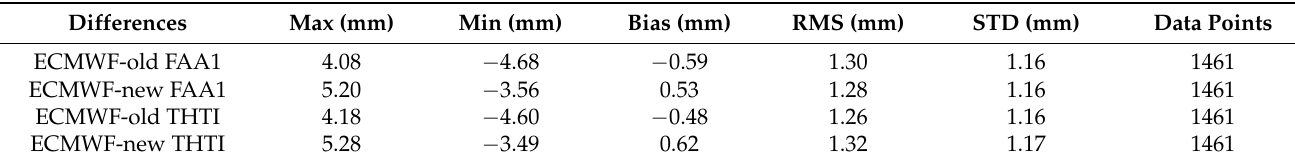
Table 6. Statistical summary for the comparison between the new/old SAAS ZHD estimates and the and RMS, for Figure 6c,d.